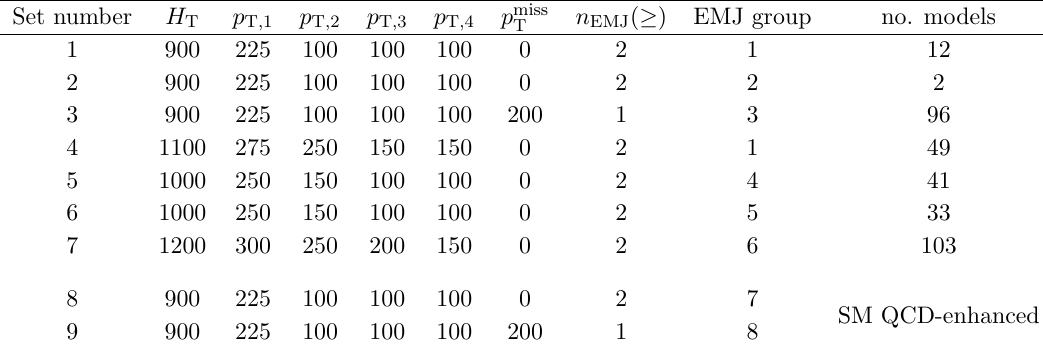
Table 3 . The seven optimized selection sets used for this search, and the two SM QCD-enhanced selections (sets 8 and 9) used in tests of the background estimation methods. The headers of the columns are: the scalar p T sum of the four leading jets ( H T ) [GeV], the requirements on the p T of the jets ( p T ; i ) [GeV], the requirement on p miss [GeV], the minimum number of the four leading jets T that pass the emerging jet selection ( n EMJ ), and the EMJ criteria group described in table 2. The last column is the total number of models de(cid:12)ned in table 1 for which the associated selection set gives the best expected sensitivity.